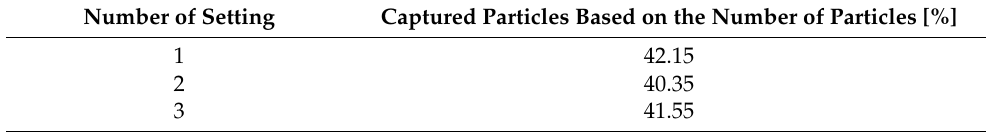
Table 4. The impact of changeable parameters of the baffle.